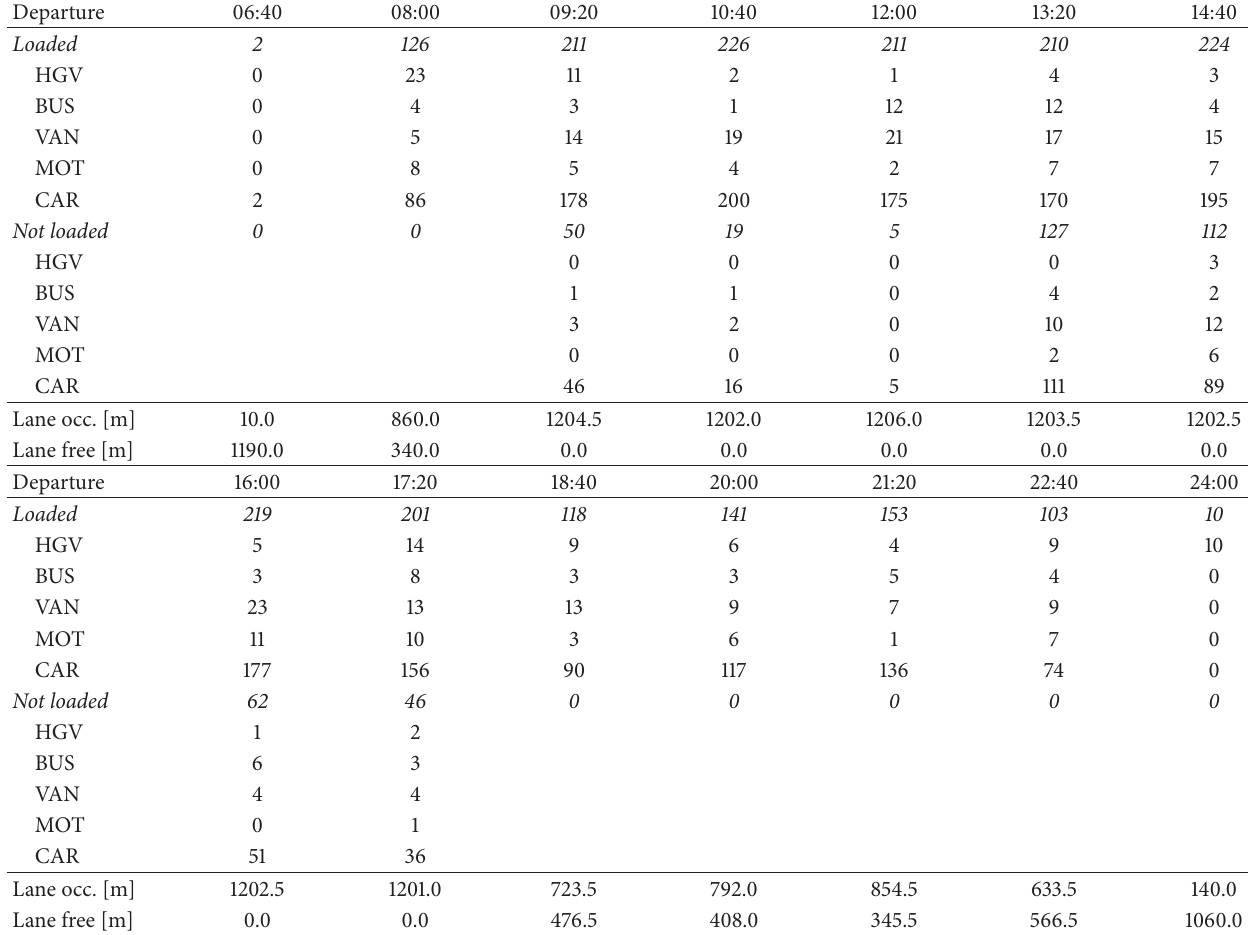
Table 5: Vehicles embarking on any run of the ferry, second